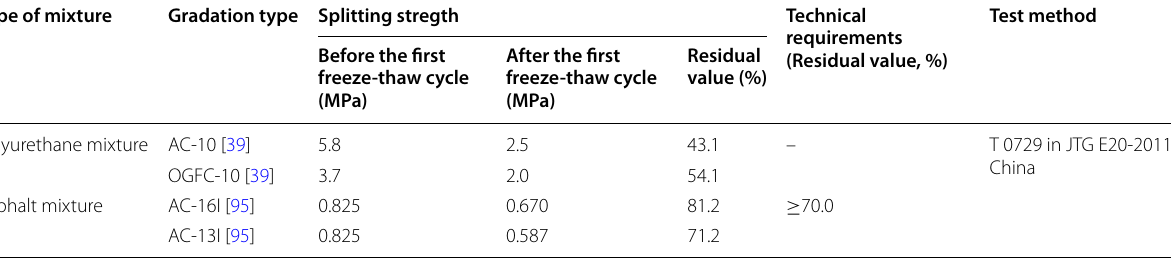
Table 4 The splitting strength of the polyurethane mixture used for tunnel pavement, compared to the conventional asphalt mixture Type of